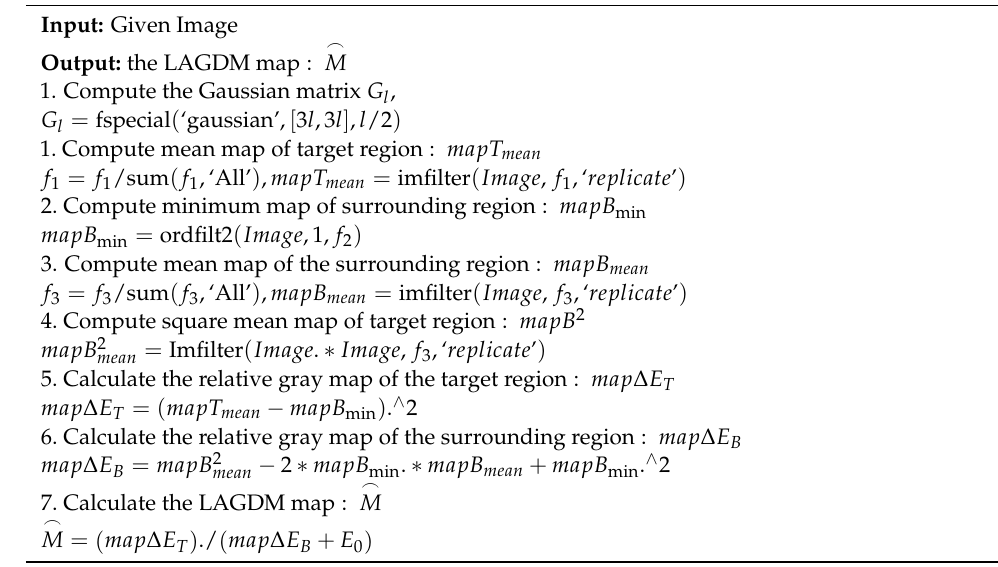
Algorithm 2: Fast Calculation Process of LAGDM